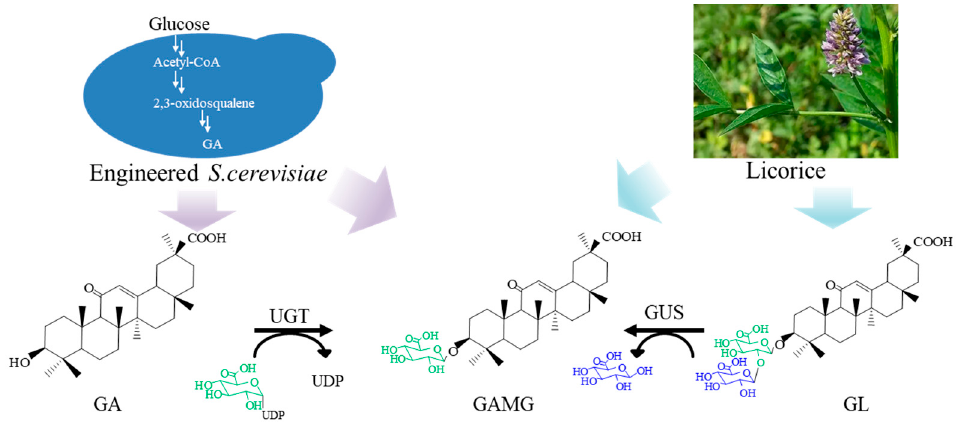
Figure 1. Biosynthesis of glycyrrhetic acid 3- O -mono- β -d-glucuronide (GAMG) from glycyrrhetic acid (GA) catalyzed by glycosyltransferase (UGT) or glycyrrhizin (GL) catalyzed by β -glucuronidase (GUS).